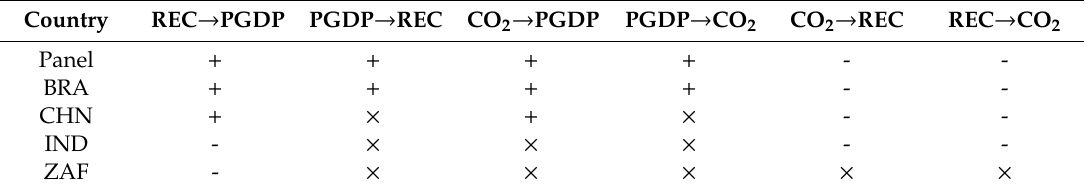
Table 10. Summary of results of the relationship between real output, renewable energy consumption and CO 2